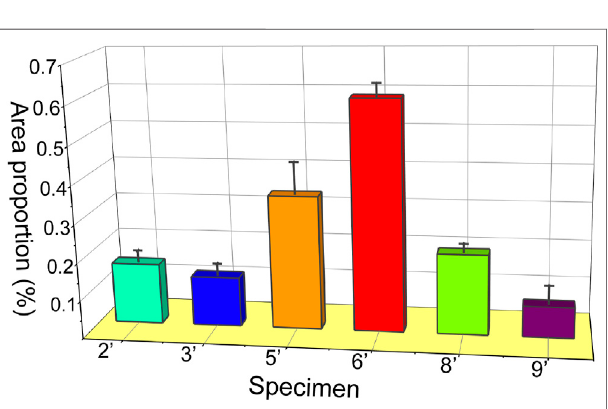
FIGURE 6 | Area ratio of modi fi er and